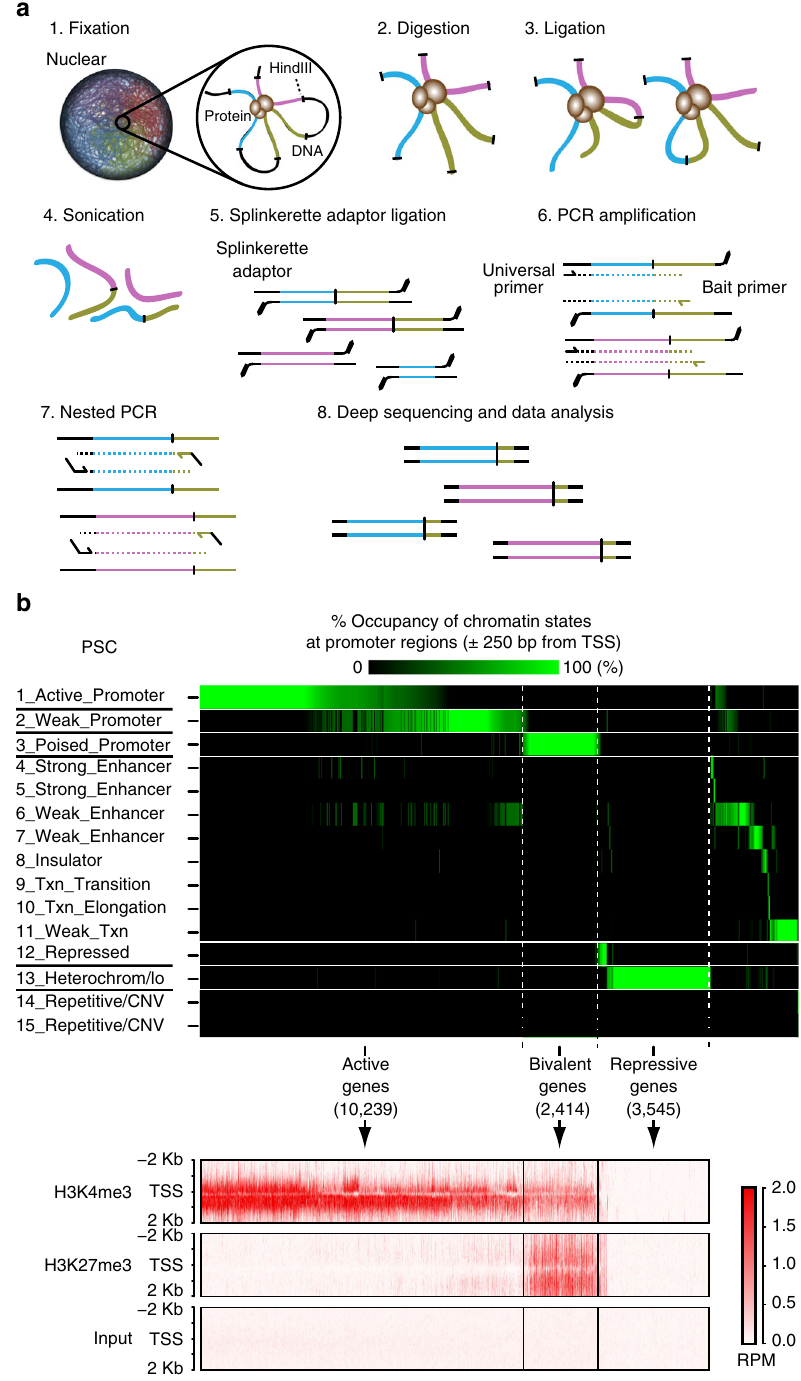
Fig. 1 ms4C-seq and de fi nition of genes by chromatin states. a Schematic diagram of ms4C-seq. Step 1: fi xation of a nucleus with formaldehyde. Step 2: digestion of DNA with Hin dIII restriction enzyme. Step 3: preparation of chimeric fragments that are derived from physical proximity ligation of DNA. Step 4: fragmentation of those chimeric fragments. Step 5 – 7: ligations of Splinkerette adapter 22 and ampli fi cations of target loci by nested PCR with a universal primer for the adaptor and speci fi c primers designed for bait loci. Step 8: deep sequencing by a next-generation sequencer. See also Supplementary Table 1 and Methods for details. b De fi nition of transcriptional states of 18,984 genes (bivalent, active, repressive, and other gene groups). The top heat map represents the occupancy of each chromatin state (%) within TSS ± 250 bp for all refseq genes in PSCs (ESCs). Bottom heatmaps indicate H3K4me3 and H3K27me3 modi fi cation pro fi les (RPM values) around TSS for active, repressive, and bivalent genes de fi ned by chromatin states in PSCs (ESCs). Histone modi fi cation pro fi les are shown within TSS ± 2 Kb NATURE COMMUNICATIONS | 8: